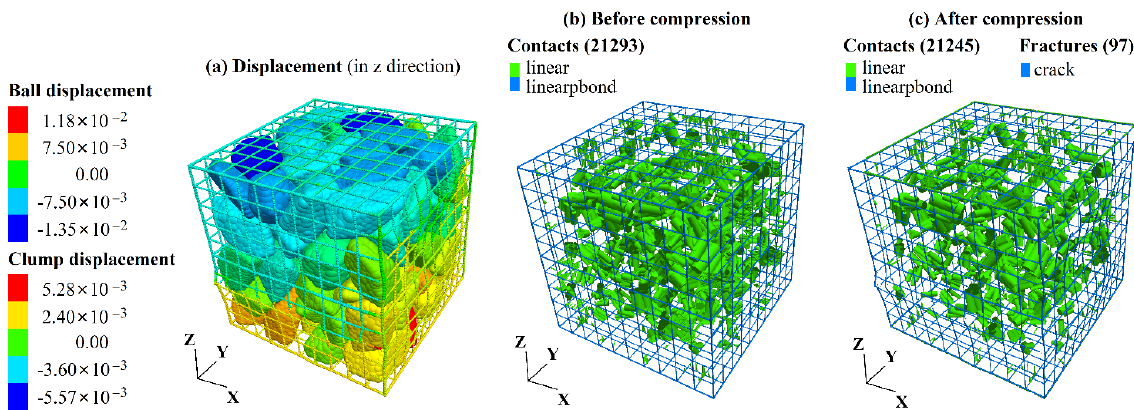
Figure 9. Uniaxial compression simulation in PFC3D.